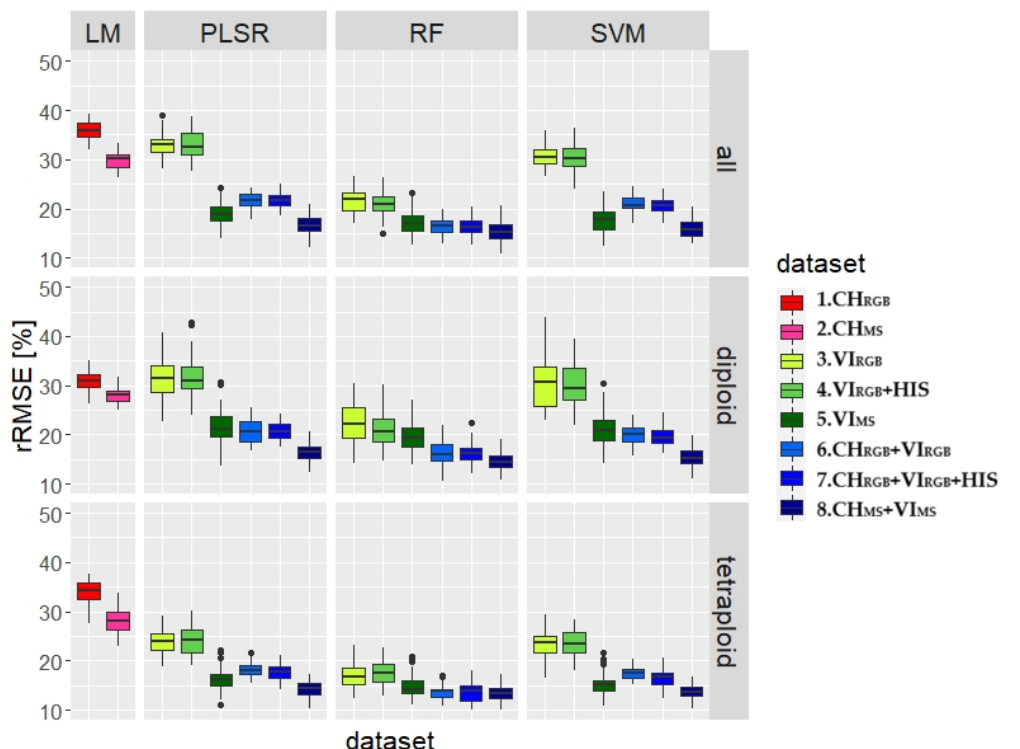
Figure 7. Box plots of relative root mean square error (rRMSE, %) computed for each tested dataset and learning algorithms (linear model (LM), Partial Least Squares Regression (PLSR), Random Forest (RF), Support Vector Machine (SVM)). RGB- based (1.CH RGB ) and MS-based canopy height model information (2.CH MS ) was used as a reference model. Vegetation Indices based on RGB sensor (3.VI RGB ); Vegetation Indices relying on RGB camera combined with information from HIS colour space (4.VI RGB + HIS), and finally, Vegetation Indices based on MS sensor (5.VI MS ) were selected as spectral features. In the last step, structural and spectral information were fused together (6.CH RGB + VI RGB ), (7.CH RGB + VI RGB + HIS), and (8.CH MS + VI MS ). Models were built with data collected separately before all three cuts for diploid, tetraploid and both ploidy levels combined (all plots).